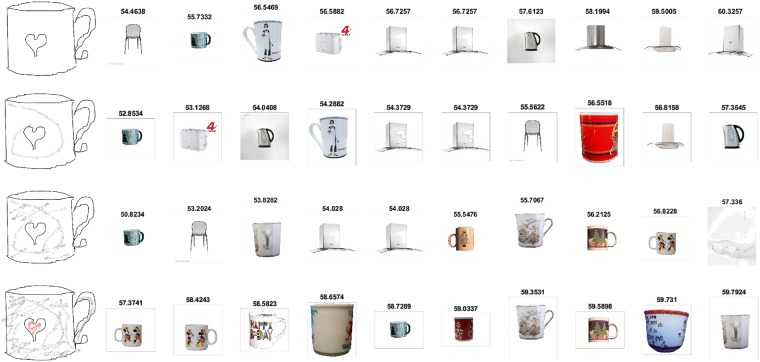
Effect of color/shade on retrieval performance.